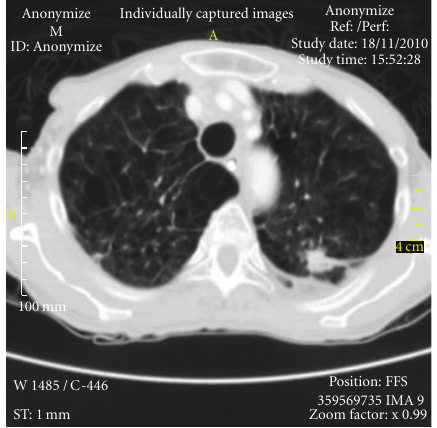
Figure 1: Thoracic computed tomography scan. It showed an elongated noncalcified image, with irregular contours, measuring approximately 2.8cm × 1.4 cm, in the upper left lobe, contiguous to an area of pleural thickening, and large areas of emphysema.